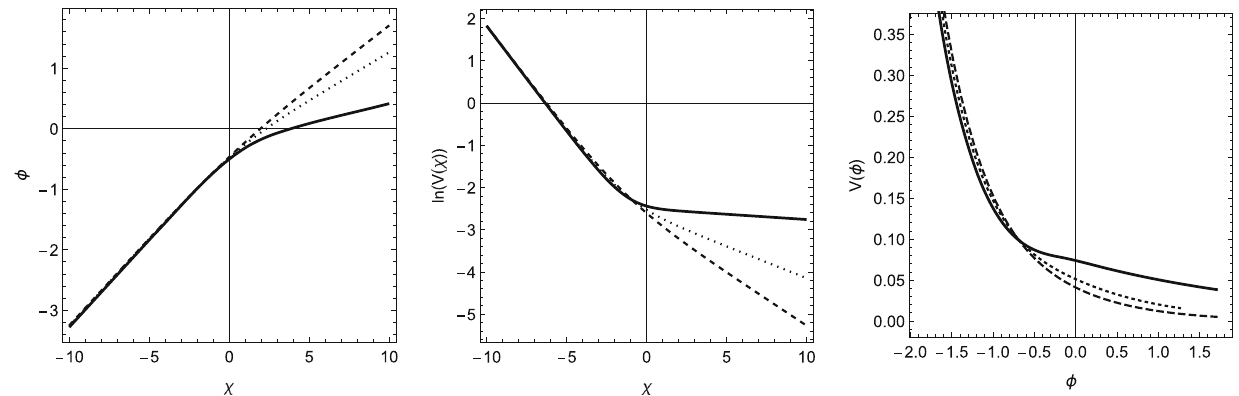
Fig. 1 Qualitative evolution for the scalar field φ (χ) (left figure) and the scalar field potential V (χ) (middle figure). Plots are for ¯ A = 1 and α = 1. Solid lines are for ω = − 0 . 95 , dotted lines are for ω = − 0 . 7 and dashed lines are for ω de de φ (χ) − V (φ (χ))